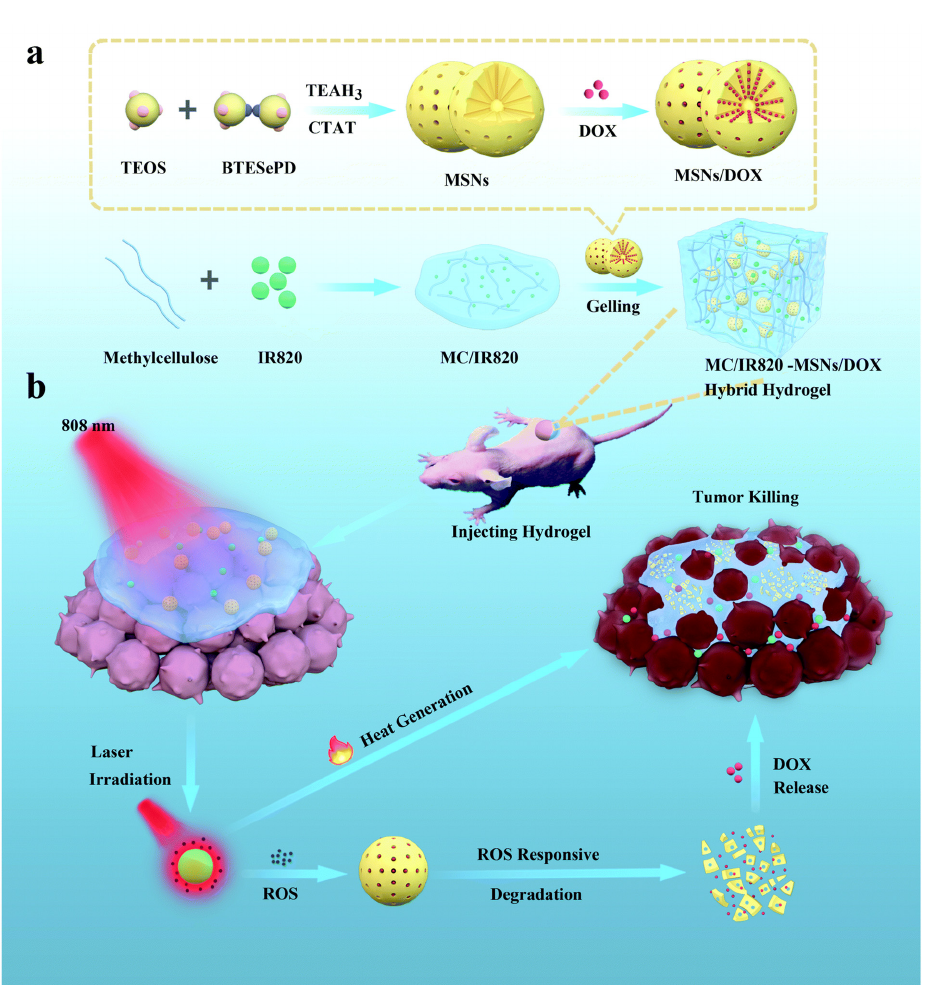
Figure 5. ( a ) The preparation of NIR-responsive MC/IR820-MSNs/DOX and ( b ) its use in the local- ized synergistic photochemotherapy of OSCC. Reprinted with permission [143]